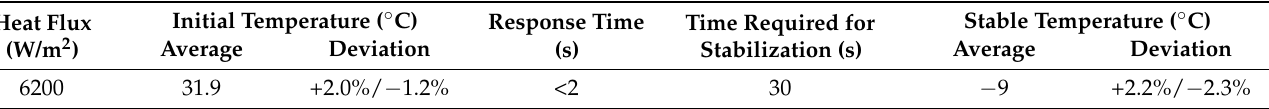
① Figure 17. Change curve of temperature over time with the decrease of 40 K under 10,000 W/m 2 heat flux.